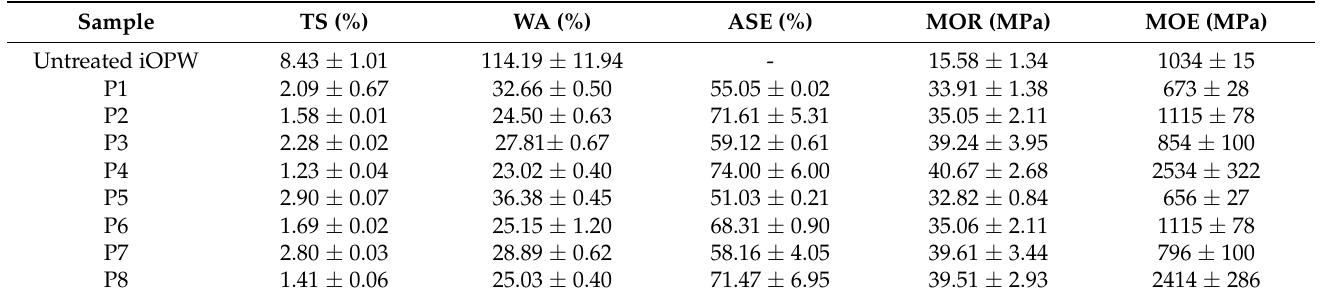
Table 6. Thickness swelling (TS), water absorption (WA), anti-swelling efficiency (ASE), modulus of rupture (MOR), and modulus of elasticity (MOE) of laminated compreg